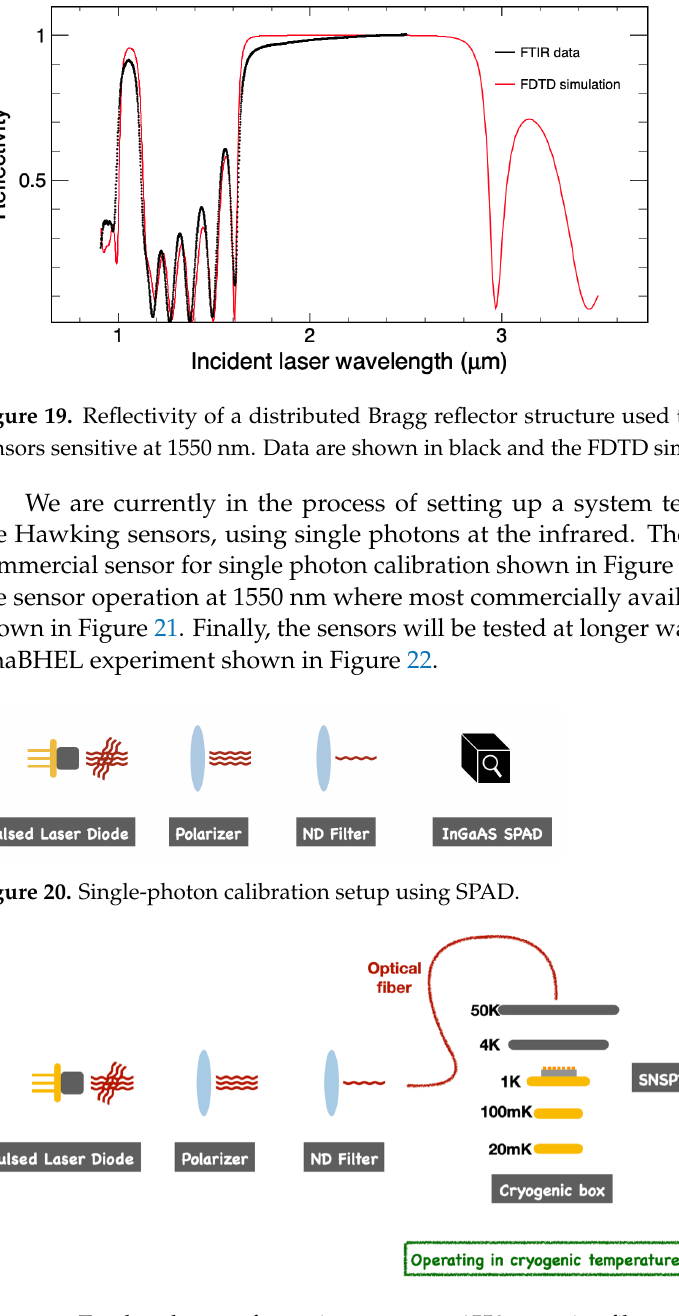
Figure 21. Test-bench setup for testing sensors at 1550 nm using fibers connected to